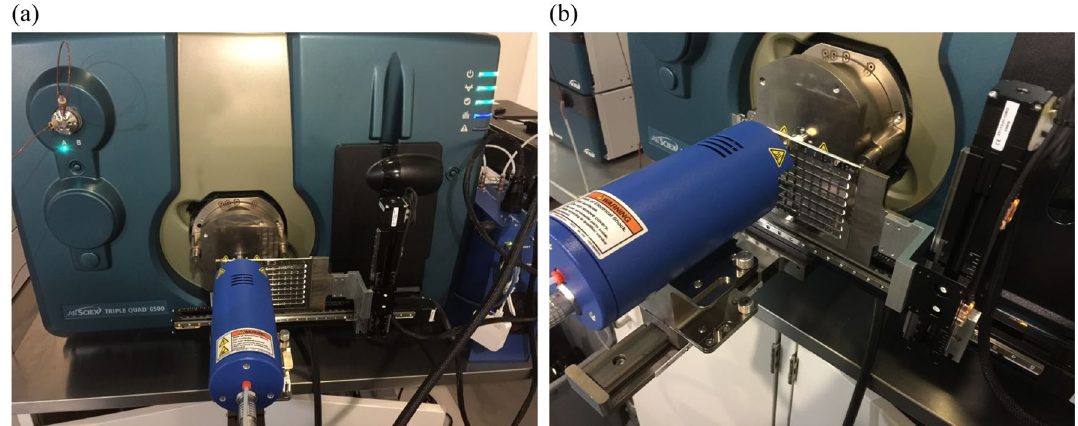
Figure 1. DART coupled with triple quadrupole mass spectrometry. ( a ) Front view; ( b ) side